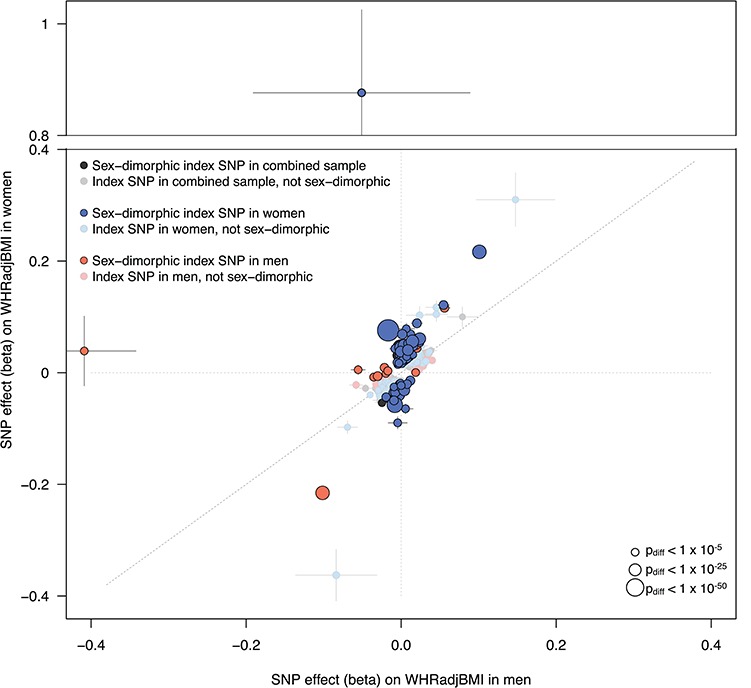
Sex-dimorphic association signals in fat distribution. For each associated locus from either the combined or sex-specific meta-analyses, we tested the index SNP for sex dimorphism. We plot here all index SNPs from each of the three meta-analyses (combined, women only and men only). SNPs that are significantly sex-dimorphic (Pdiff < 3.3 × 10−5) are represented by boldly colored circles, while index SNPs that are not sex-dimorphic are plotted with faded colors. Despite the expectation that SNPs identified in the combined sample (men and women, grey points) will be biased away from sex dimorphism and index SNPs identified in the sex-specific sample will be biased towards sex dimorphism (due to winner’s curse), we observed stronger effects in women across all SNPs. Of the index SNPs from the men-only analysis (orange points), 14% showed evidence of sex dimorphism. In contrast, ∼29% of the index SNPs from the women-only analysis (blue points) show evidence of dimorphism. Of all sex-dimorphic SNPs, 92.4% show a stronger effect in women compared to men. Points are sized by the -log10(Pdiff) of the sex-dimorphism test. Horizontal bars indicate standard error in men; vertical bars indicate standard error in women.